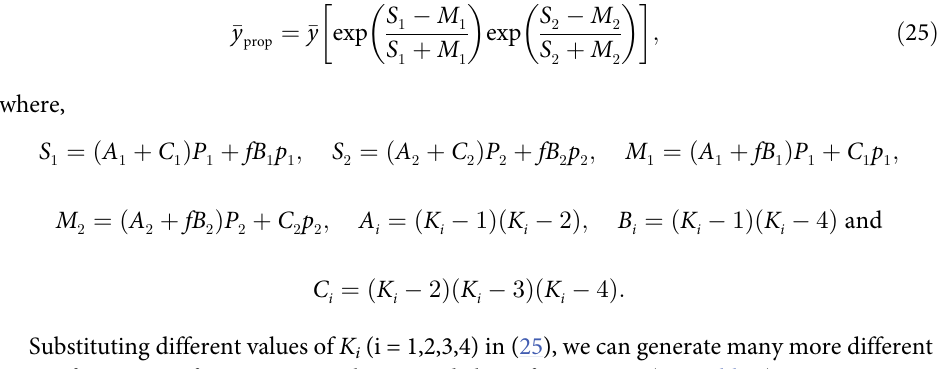
Substituting different values of K (i = 1,2,3,4) in (25), we can generate many more different i types of estimators from our general proposed class of estimators (see Table 1). Solving � y given in Eq (25) in terms of errors, we have prop